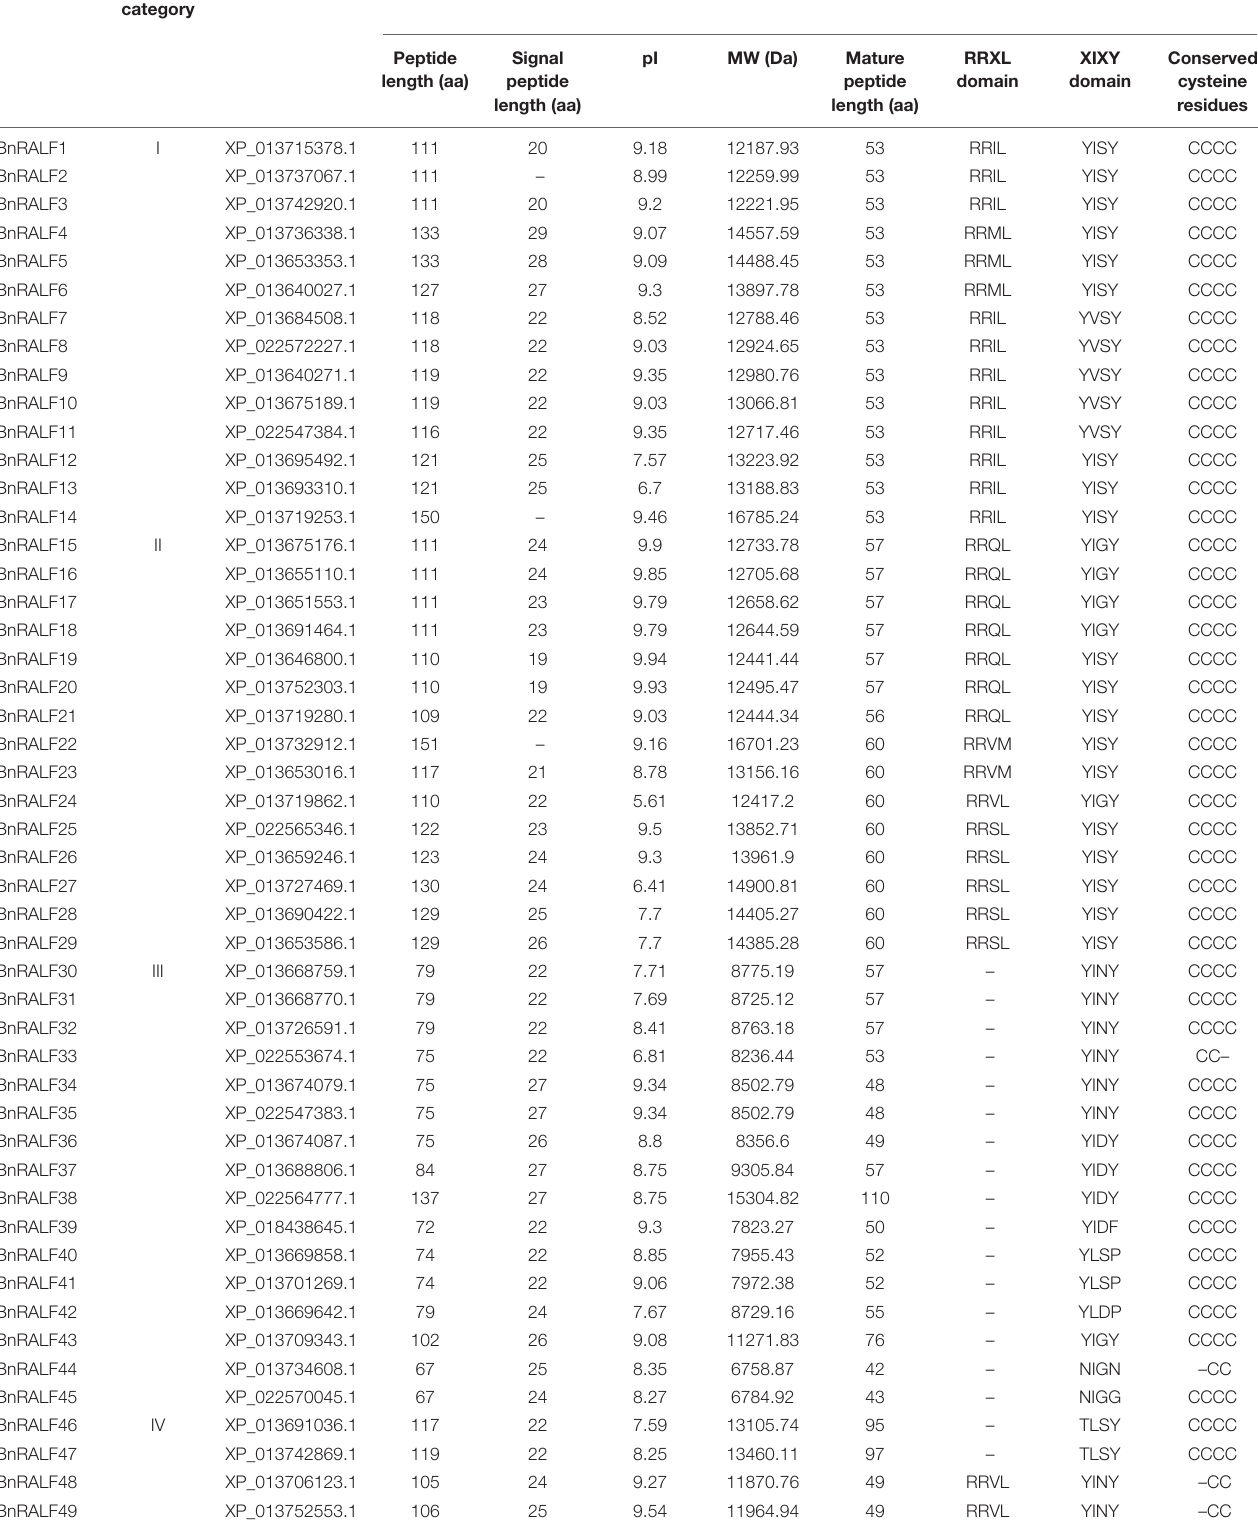
TABLE 1 | List of BnRALFs identified in this